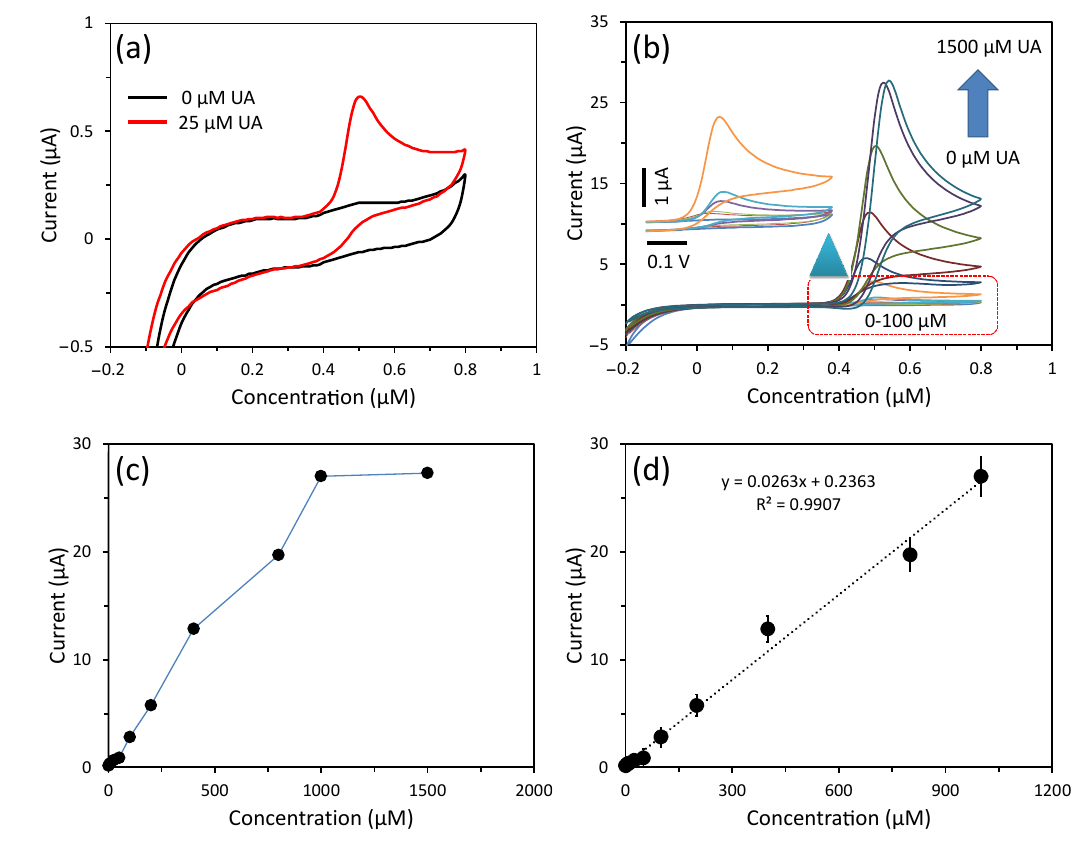
Figure 5. ( a ) CV response of cobalt oxide puffy balls/GC sensor towards 0 µ M and 25 µ M UA concentration and ( b ) CV response for 0 to 1500 µ M UA concentration in PBS buffer (pH = 7.4). ( c ) current response vs. UA concentration plot, and ( d ) calibrated plot showing slope (0.0263 µ A/ µ M) and regression coefficient (R 2 ) of 0.9907. Inset b presents CV response at a low-concentration range (0 to 100 µ M) of UA. Table 1. Comparison of electrochemical non-enzymatic UA sensing performance of cobalt oxide puffy balls/GC sensor with previously published